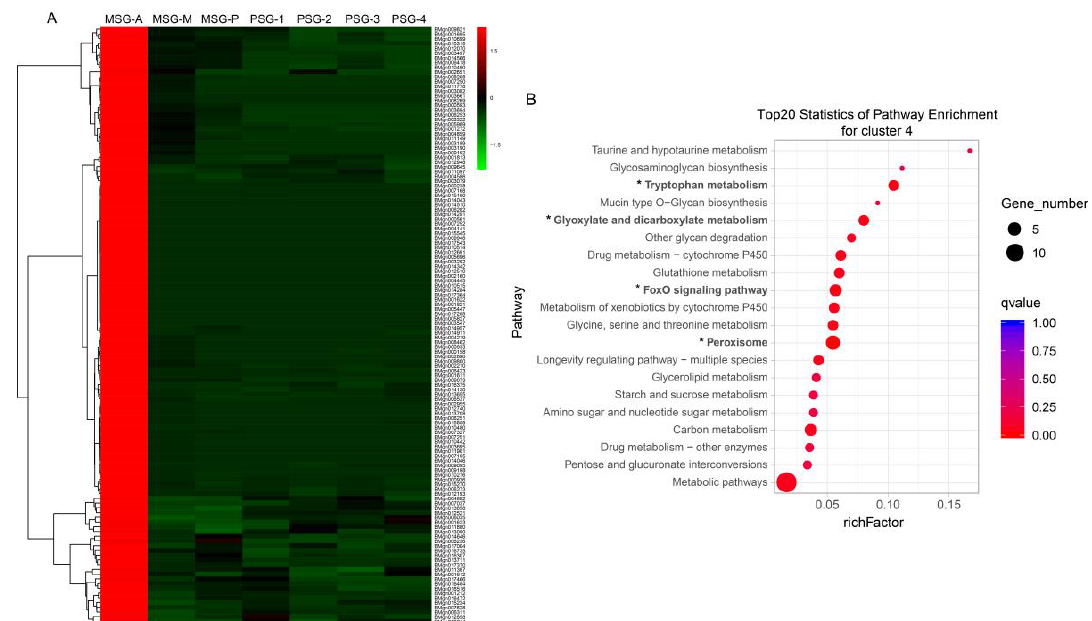
Figure 4. Cluster and KEGG enrichment analysis of MSG-A highly expressed genes. ( A ) Hierarchical clustering of high expression genes in the MSG-A. ( B ) KEGG pathway enrichment analysis of high expression genes in the MSG-A. “*” (qvalue < 0.05) represents a significantly enriched pathway.